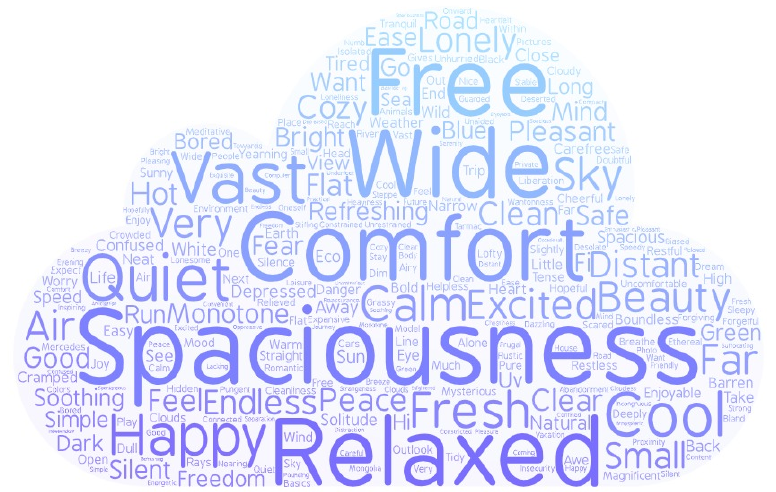
Figure 5. The word clouds in the spacious environment.